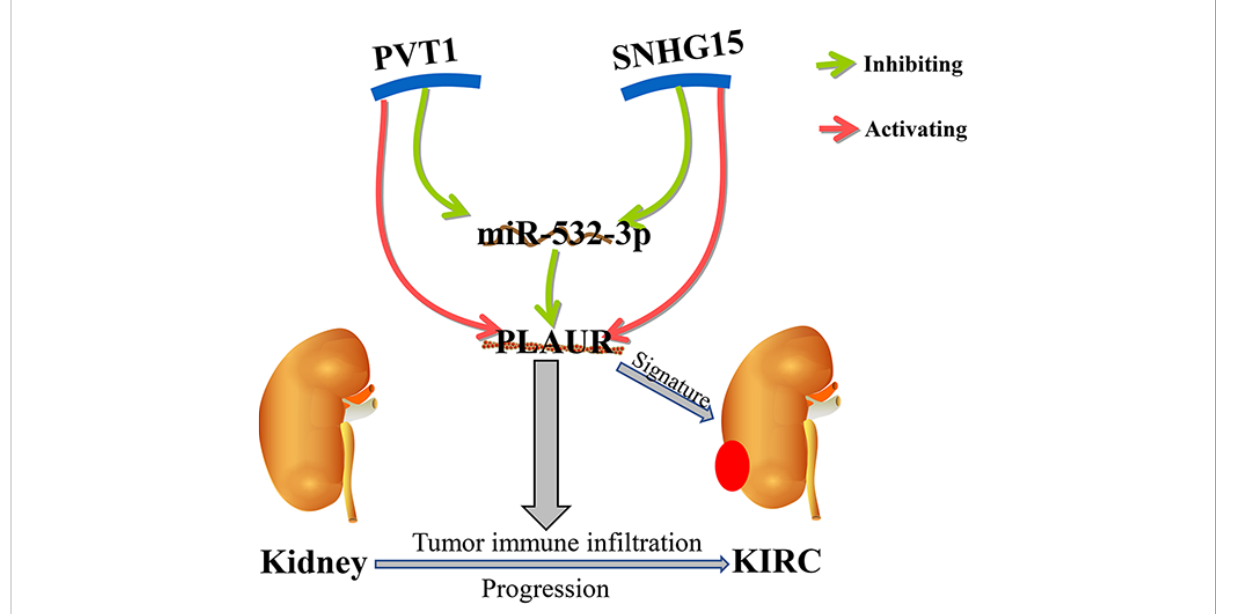
FIGURE 11 The model of PVT1/SNHG15-hsa-miR-532-3p-PLAUR axis in carcinogenesis of